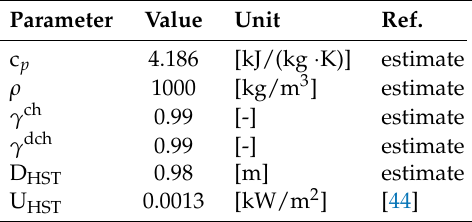
Table A6. Parameter data (HST).